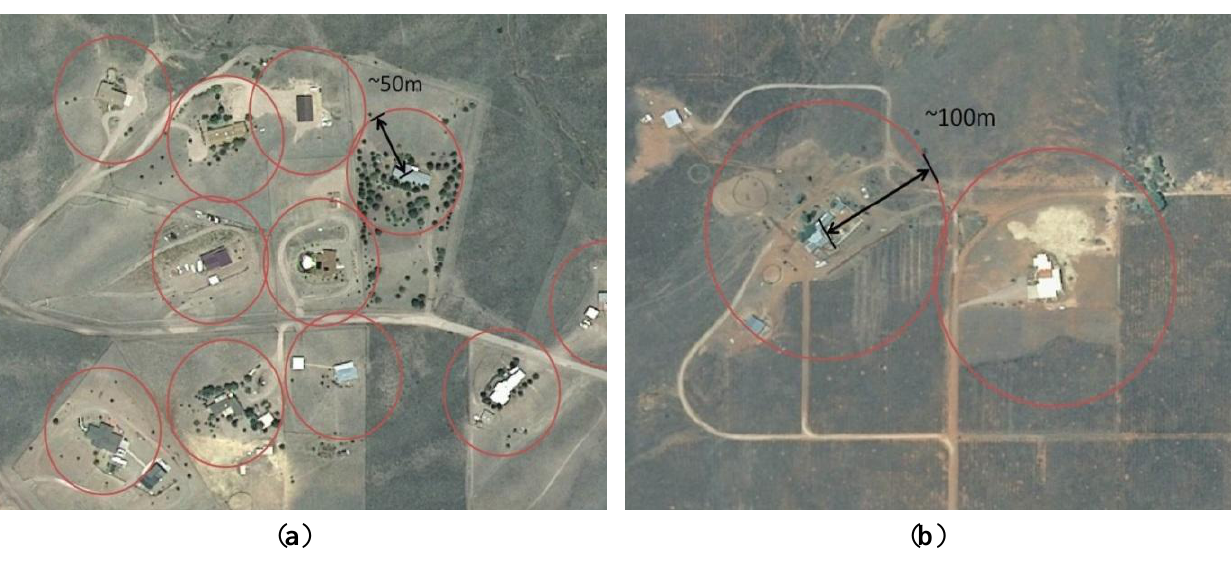
Figure 3. 2010 1-m NAIP photos showing ( a ) concentrated generalized distance effects on houses, and ( b ) diffuse distance effects of houses. Near Sonoita, AZ,